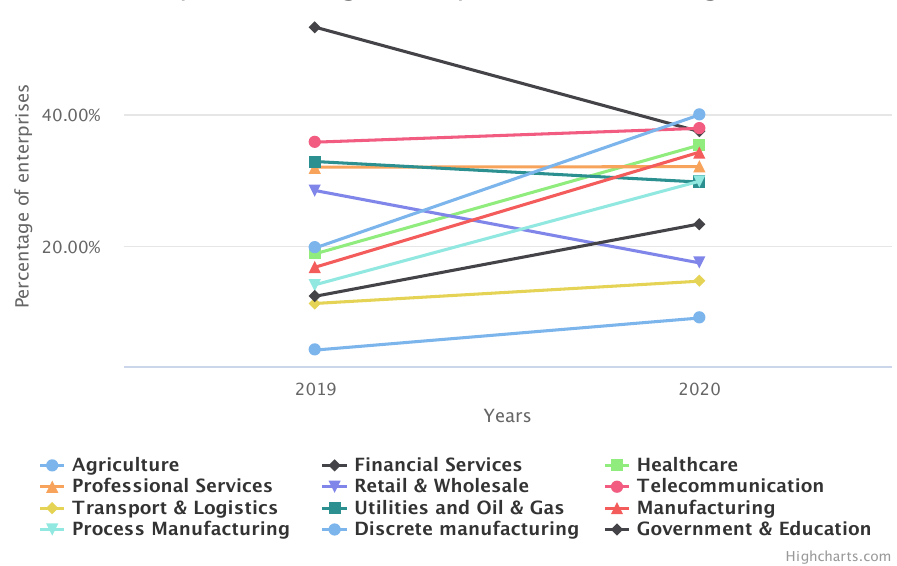
Figure 3. Trend in percentage uptake of advanced technology in 2019 and 2020. Generated with https: //ati.ec.europa.eu/data-dashboard (accessed on 8 April